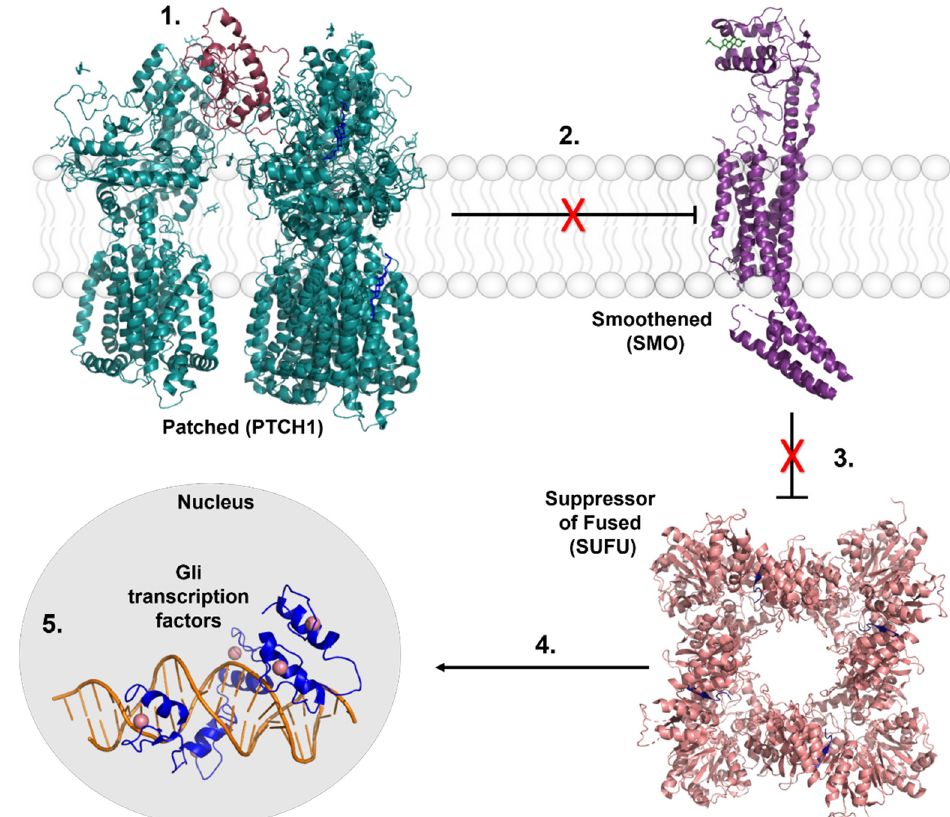
Figure 2. Key regulators of the Hedgehog signaling cascade. 1. Hh signaling is activated by the binding of Hh ligands (Sonic Hedgehog, Indian Hedgehog, and Desert Hedgehog) to the transmembrane protein PTCH1. 2. PTCH1 is a suppressor of SMO activity. Upon the binding of Hh proteins, inhibition of SMO is released, represented by the red X. 3. Upon activation, SMO signals for the SUFU complex to release the Gli family of transcription factors. 4. Gli transcription factors are activated in the cytosol prior to translocating into the nucleus. 5. Gli transcription factors transcribe pro-proliferative and migratory genes that lead to tumorigenesis in BCC. Crystal structures images were made from the following Protein Data Bank files: Ptch1/SHH complex, 6N7H. SMO, 6D35. SUFU/Gli complex: 4BLB. Gli1/DNA complex, 2Gli.